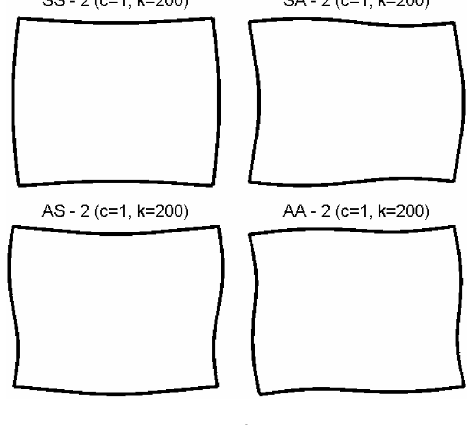
Fig. 3. Mode shapes (2 nd mode, Case 1, c = 1).